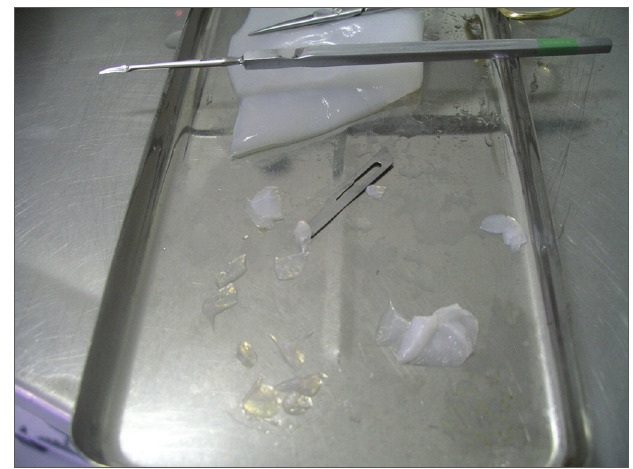
Figura 1. A manta de celulose sendo